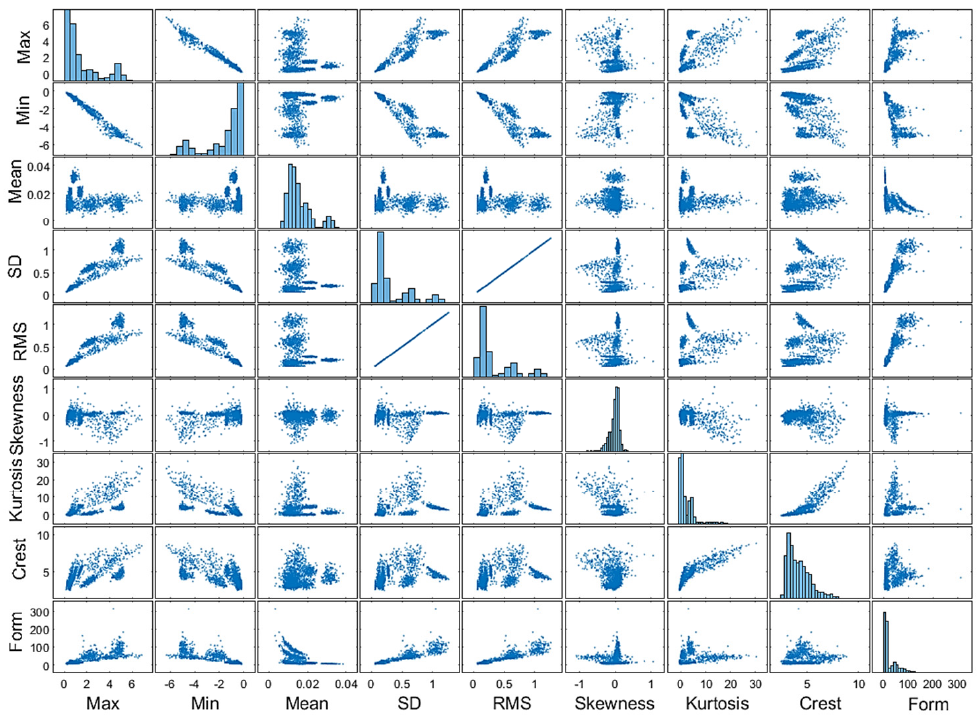
Figure 5. The correlation matrix is the distribution of the scatter diagram of nine features. The more separated the data of each category are, the easier it is to classify the data in the scatter diagram, but the classification could not be displayed in Figure 5. Therefore, in Figure 6, there are four categories: normal (light blue), ball (blue), inner ring (green), and outer ring (red). Figure 6 shows that the plot matrix created a sub-axis matrix containing row scatter plots of the nine features, which are located on the motor bearing faulty ball (blue), the inner ring (green), the outer ring (red), and normal (light blue)